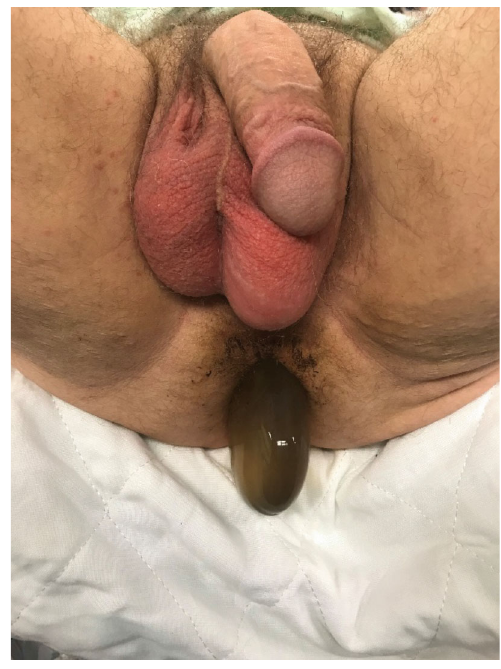
Figure 2: Inferior view of reservoir protrusion through the anus.